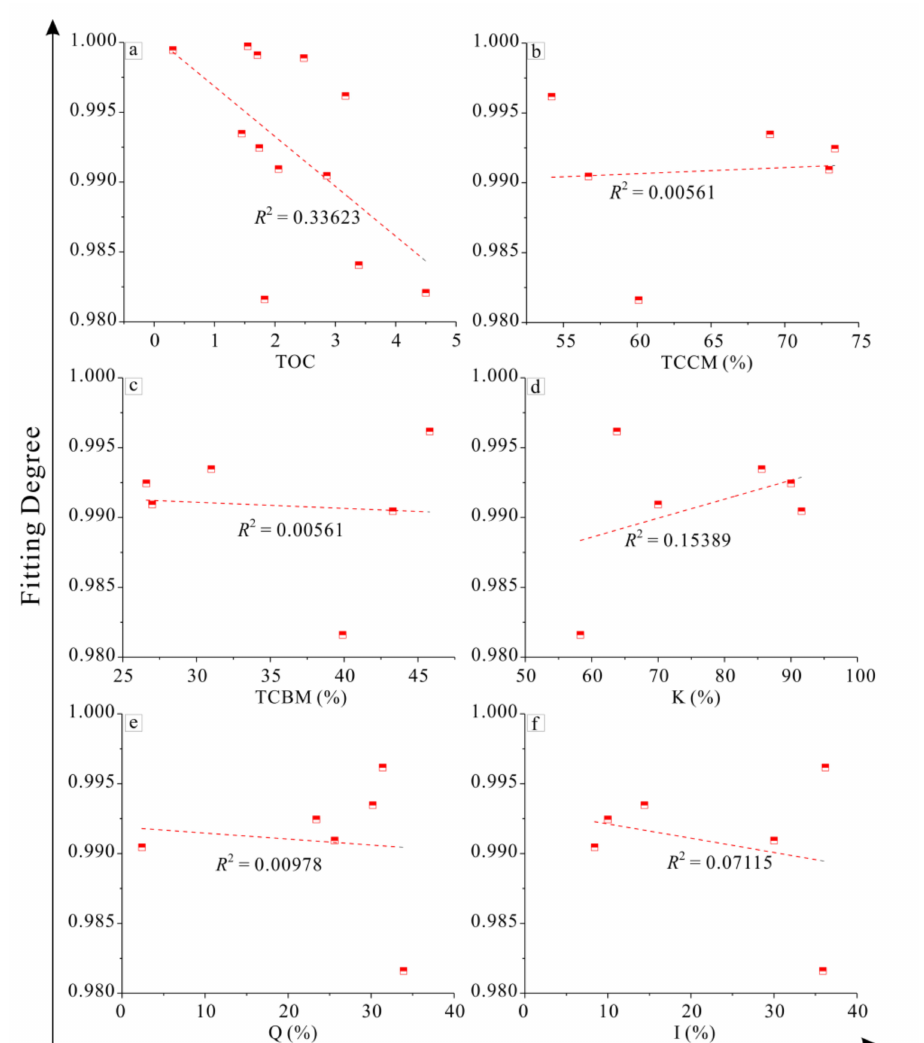
Figure 4. The correlation of fitting degree versus TOC and mineral composition. The fitting degree is the fitting effect of the Langmuir model for isothermal adsorption experimental data, where ( a ) is the correlation of fitting degree versus TOC, ( b ) is the correlation of fitting degree versus TCCM, ( c ) is the correlation of fitting degree versus TCBM, ( d ) is the correlation of fitting degree versus kaolinite, ( e ) is the correlation of fitting degree versus quartz and ( f ) is the correlation of fitting degree versus